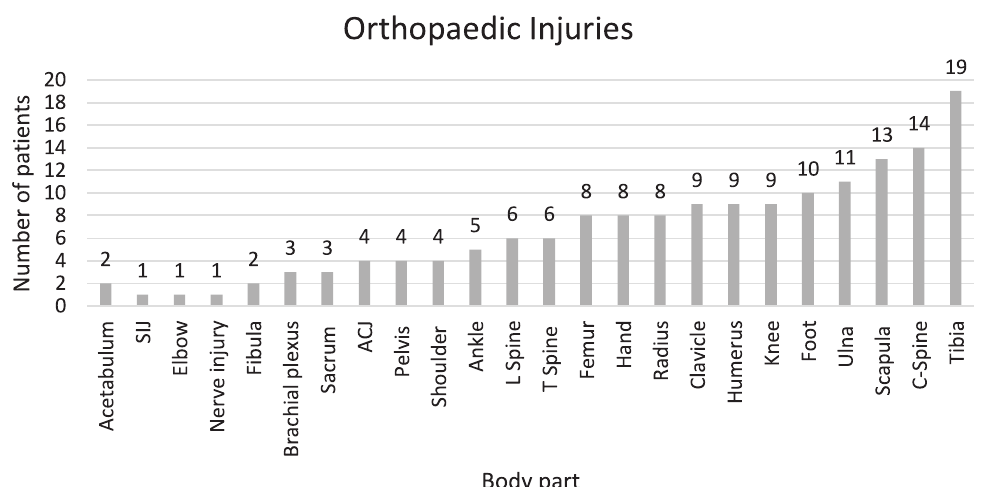
Figure 2. Orthopaedic injuries. Presentation of data showing the frequency of injuries incurred by body part. The most common fracture was the tibia ( N = 19), followed by C-spine ( N =